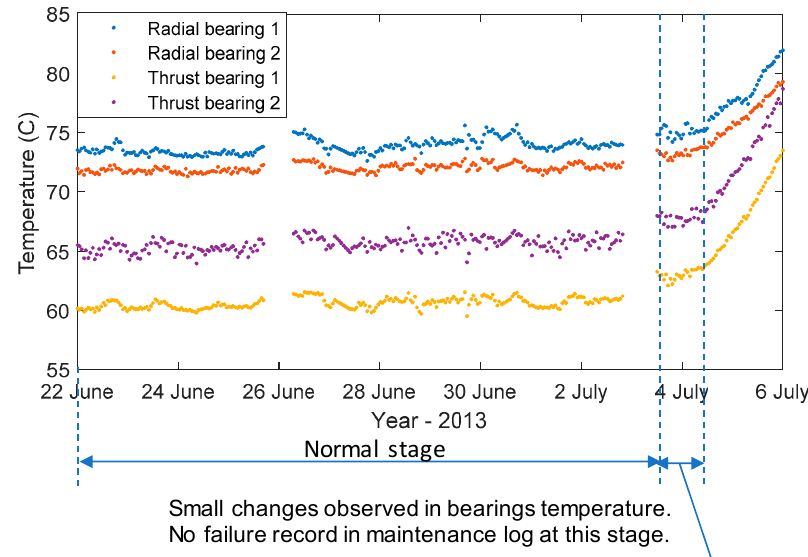
Small changes observed in bearings temperature. No failure record in maintenance log at this stage. Figure 6. Measured bearing temperature obtained from the pump ′ s condition monitoring system.